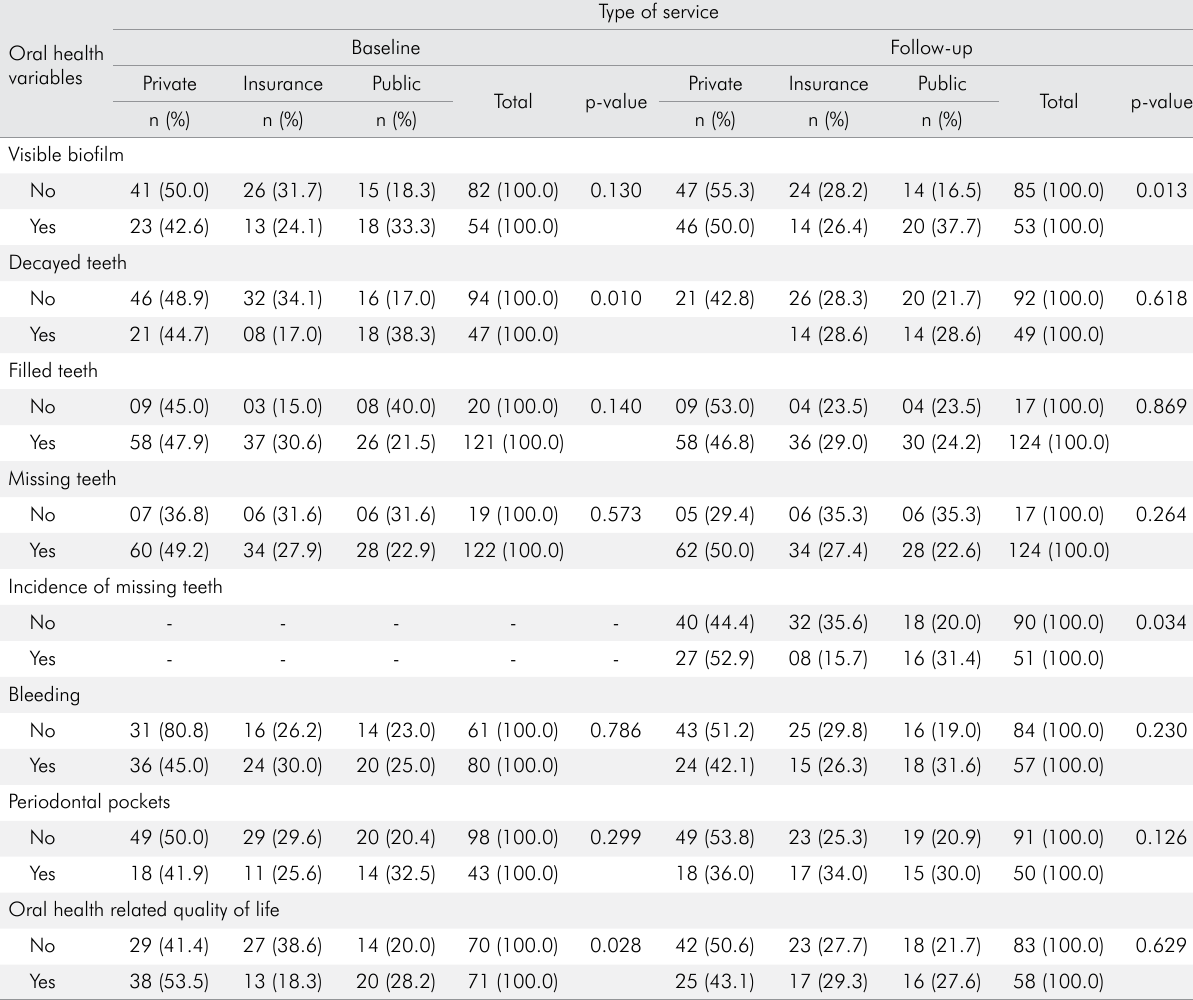
Table 3. Association between type of service used and adult oral health variables. Piracicaba, SP, Brazil, 2011-2015.